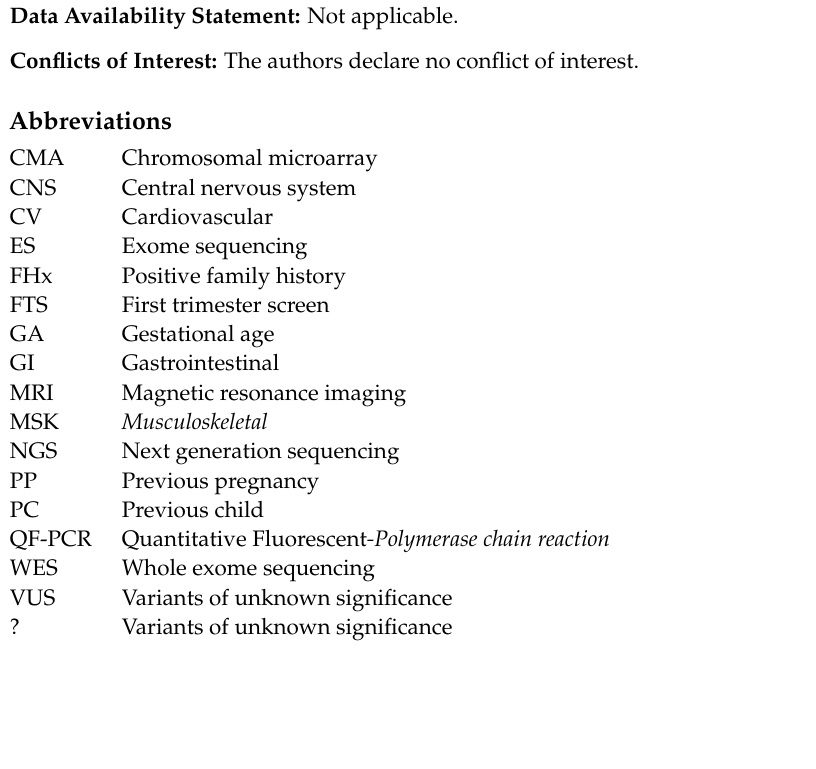
Figure S2: Distribution of fetal features by systems in relation to positive NGS-based tests (prenatal and postnatal gene panels and postnatal WES); Figure S3: Clinical workflow for testing for patients who had prenatal CMA; Figure S4. Clinical workflow for patients who had CMA either postnatally or both prenatally and postnatally; Figure S5. Clinical workflow for patient who did not have CMA or had it